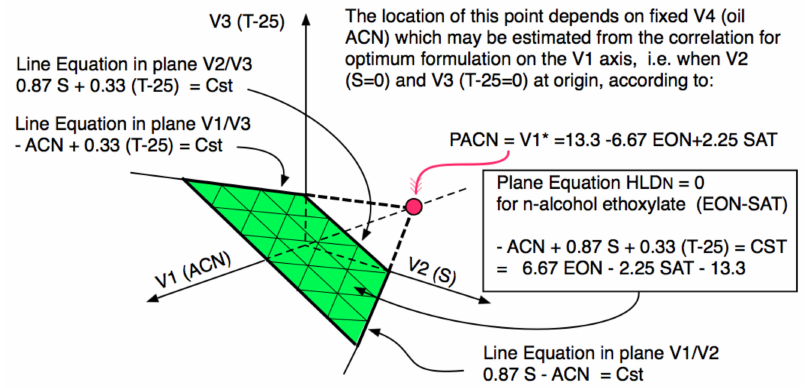
Figure 12. Tridimensional (ACN, T, S) formulation scan with the optimum formulation plane (HLD = 0) is intercepting the ACN axis at the value of the fourth variable (the preferred alkane carbon